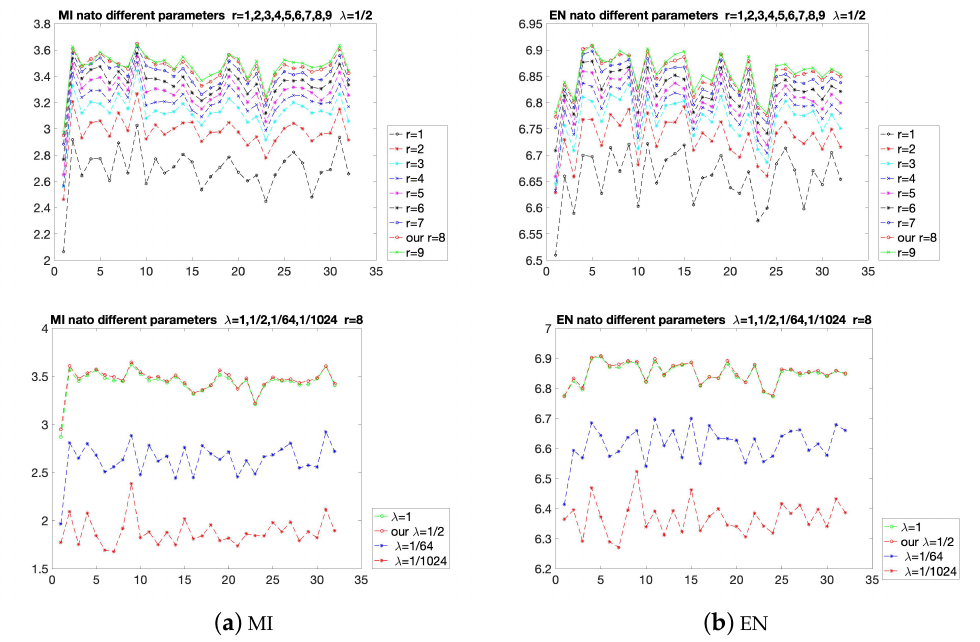
Figure 5. Quantitative comparison of the two indicators, MI and EN on the nato-camp sequences. Some different parameters are used for comparison.